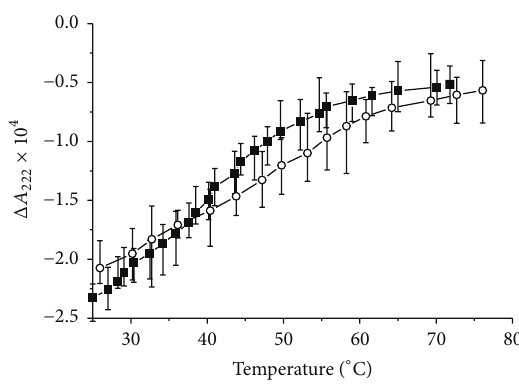
Figure4:ThemeltingcurvesofpureHMGB1( squares )andHMGB1 in the complex with DNA at 𝑟 = 0.5 ( circles ) obtained by measuring circular dichroism at 222 nm. The concentration of DNA in the sample was 30 𝜇 g/mL, and the concentration of HMGB1 was 15 𝜇 g/mL. The complex was prepared in 0.25 mM EDTA/0.2 mM NaCl solution. Optical path length was 1cm.